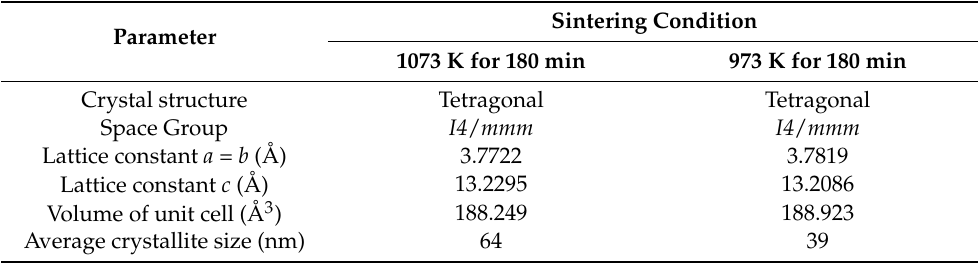
Table 1. Rietveld refinement structural parameters for La 2 − x Sr x CuO 4 nanoparticles with x = 0.20.